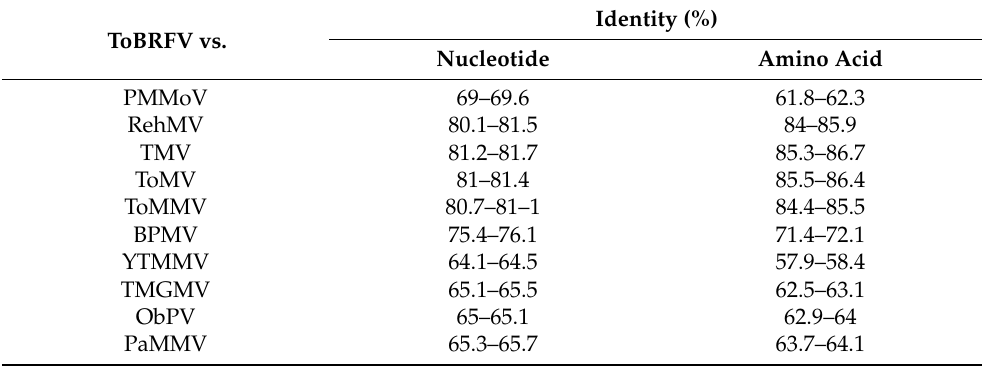
Table 4. Identity percentage of the complete genome nucleotide and amino acid sequences of ToBRFV with other Asterids-infecting